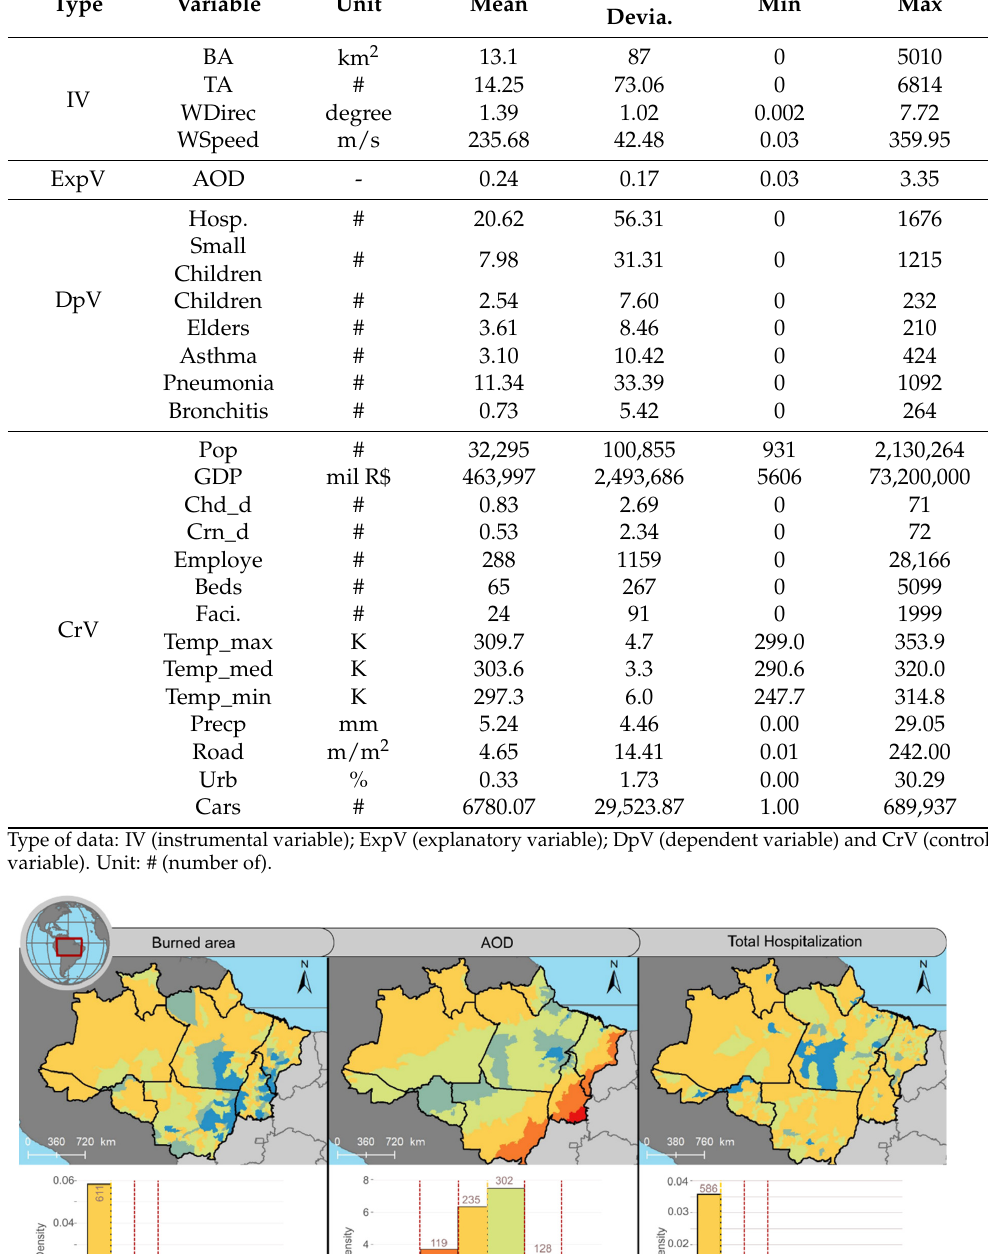
Table 2. Descriptive statistics, subdivided by variable type and calculated at a municipal–monthly level.